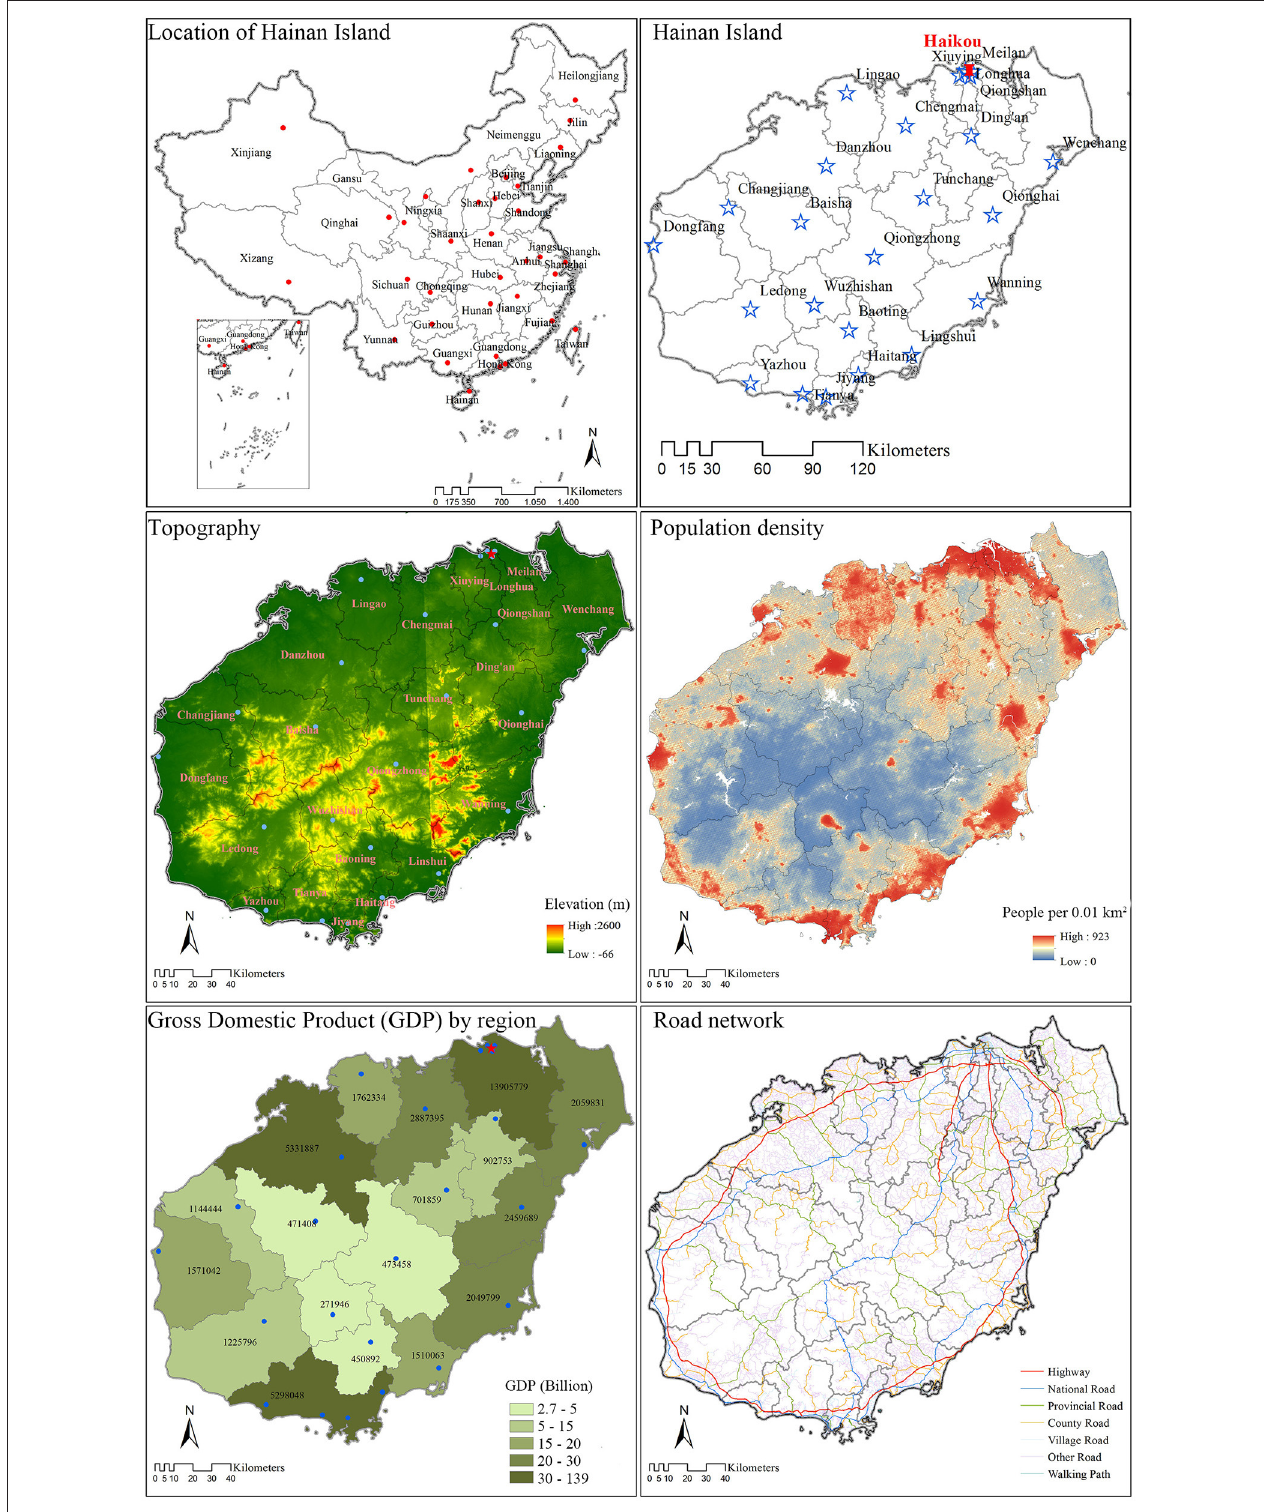
FIGURE 1 | Study area population, topography, transportation, and economic development on Hainan Island, China (2018). Distribution of study area, administrative boundaries, county centers, topography (elevation), and road network were downloaded from the National Geomatics Center of China. The Gross Domestic Product (GDP) by region indication economic development was derived from Hainan Statistical Yearbook 2019. The population density to grid level (100*100 m 2 ) was downloaded WorldPop.